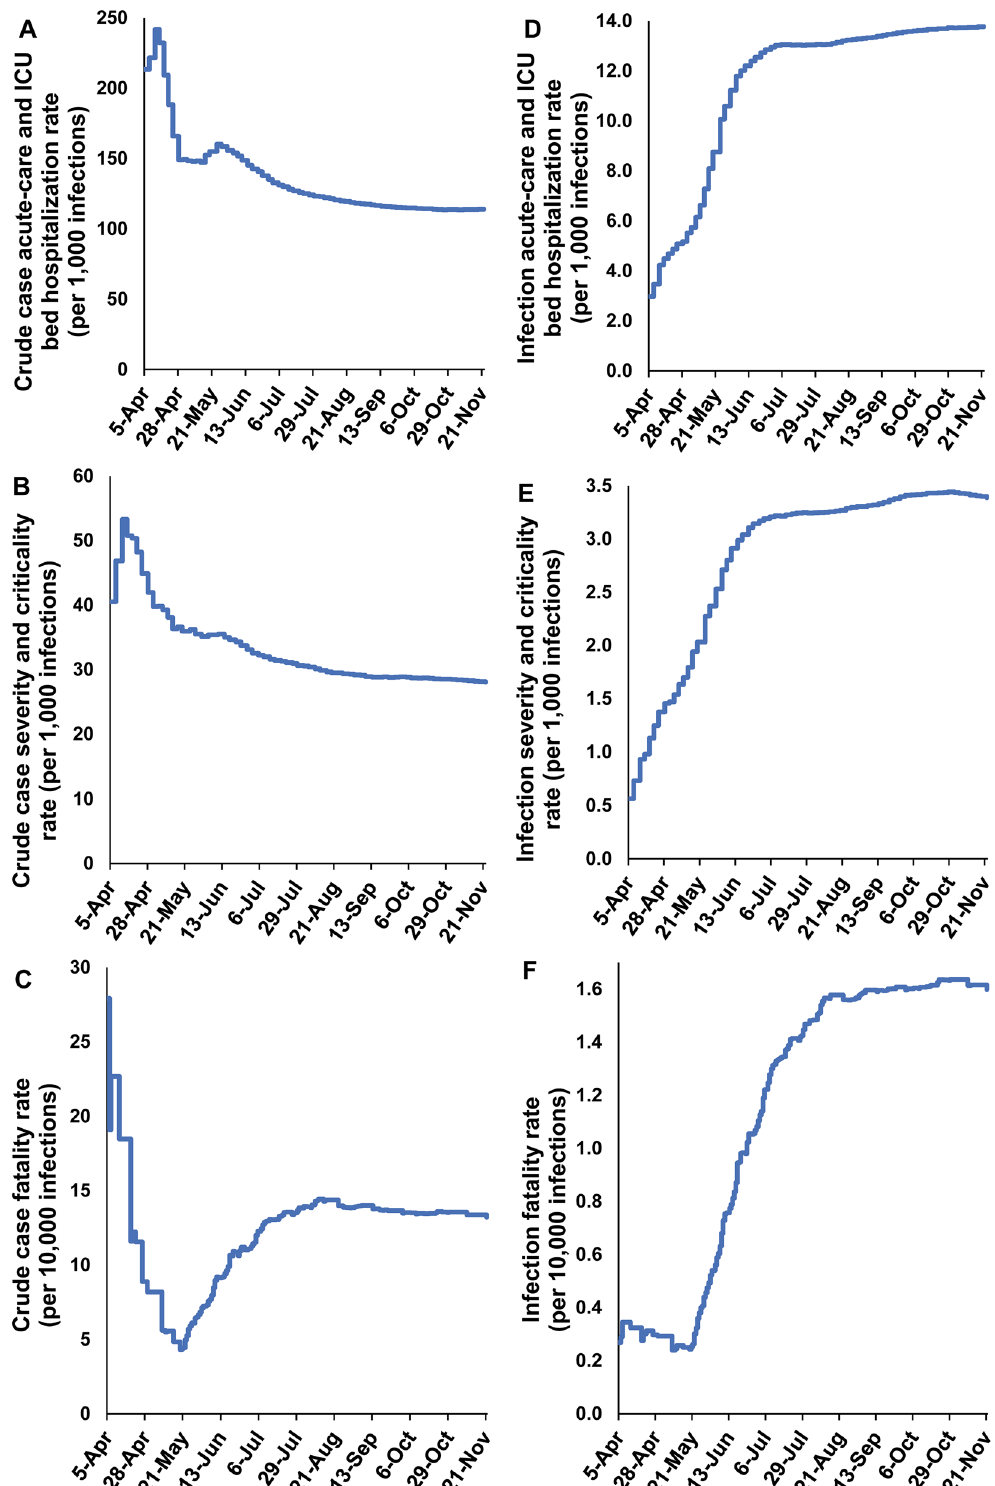
Figure 1. Temporal trend in ( A ) crude case acute-care and ICU bed hospitalization rate, ( B ) crude case severity and criticality rate, ( C ) crude case fatality rate, ( D ) infection acute-care and ICU bed hospitalization rate, ( E ) infection severity and criticality rate, and ( F ) infection fatality rate. Classification of infection severity and criticality was per WHO infection severity classification 11